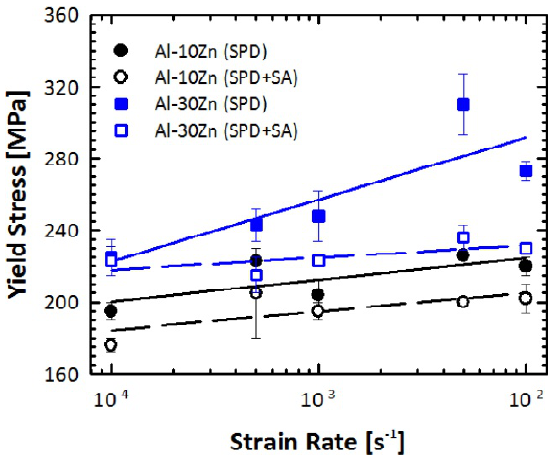
Fig. 5. Strain rate dependence of the yield stress of ultrafine grain Al-Zn alloys after severe plastic defor- mation (SPD) and after SPD followed by static an- nealing (SA) of 10 min at 200 ° C for Al-10Zn and 10 min at 250 ° C for Al-30Zn.